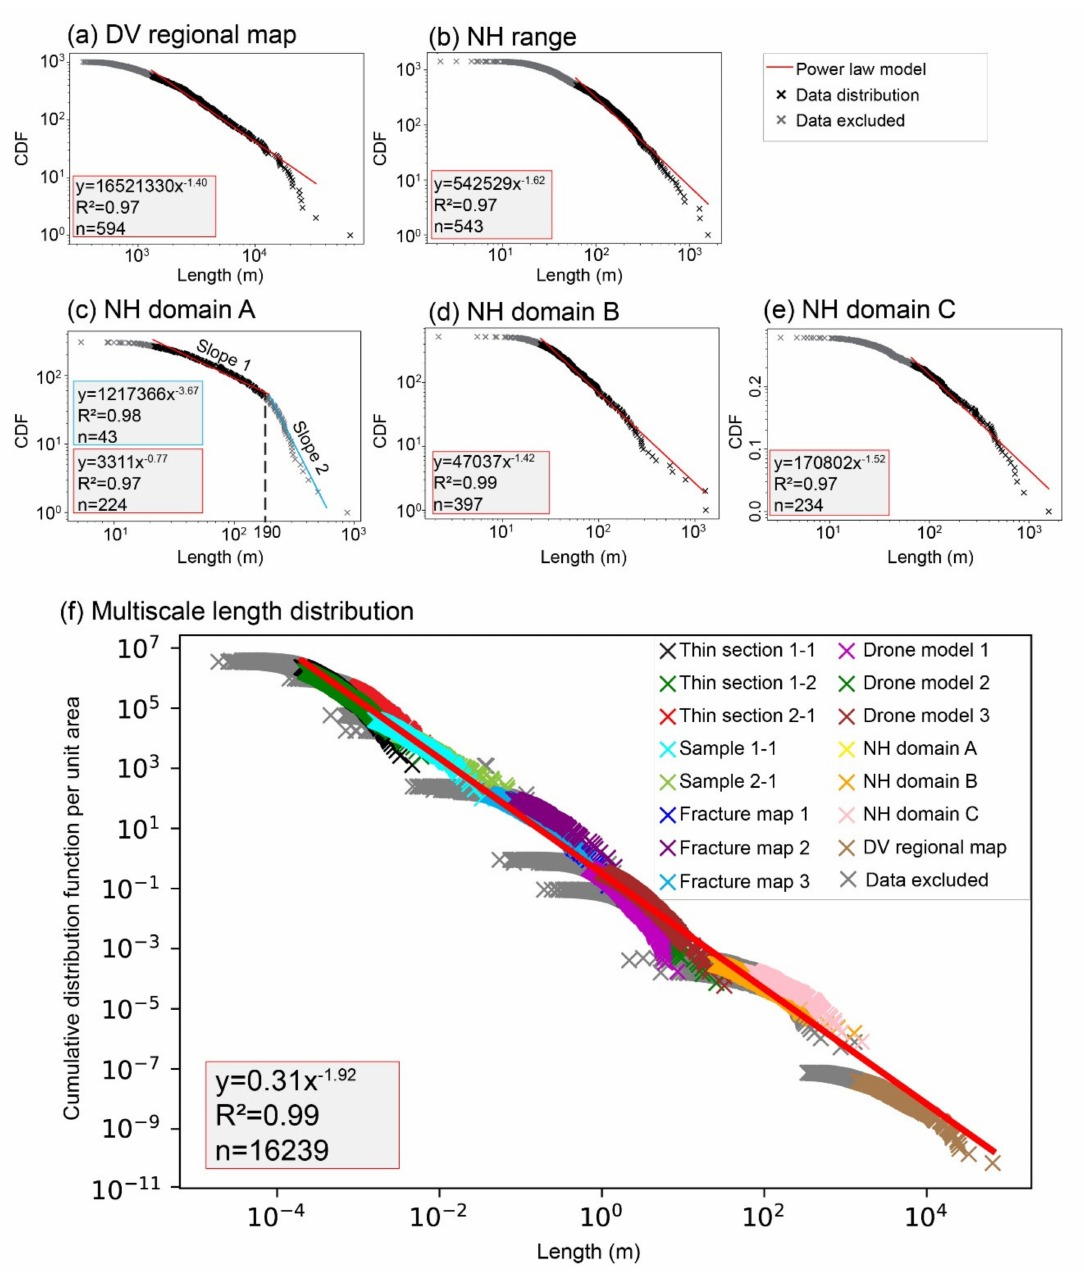
Figure 10. Fracture length distribution from ( a ) DV geological map, ( b ) NH range, ( c ) NH map domain A, ( d ) NH map domain B, and ( e ) NH map domain C, and ( f ) Multiscale length distribution obtained from the combination of the whole